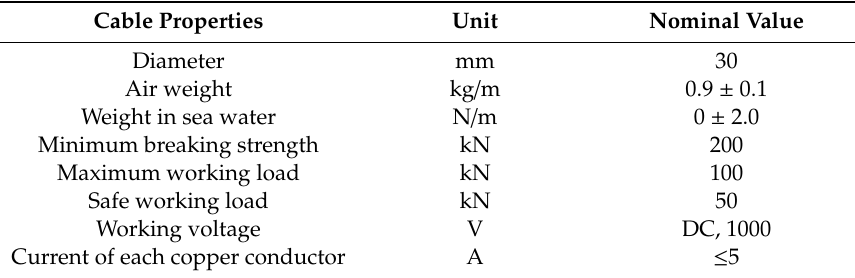
Table 2. Properties of the EOM cable.